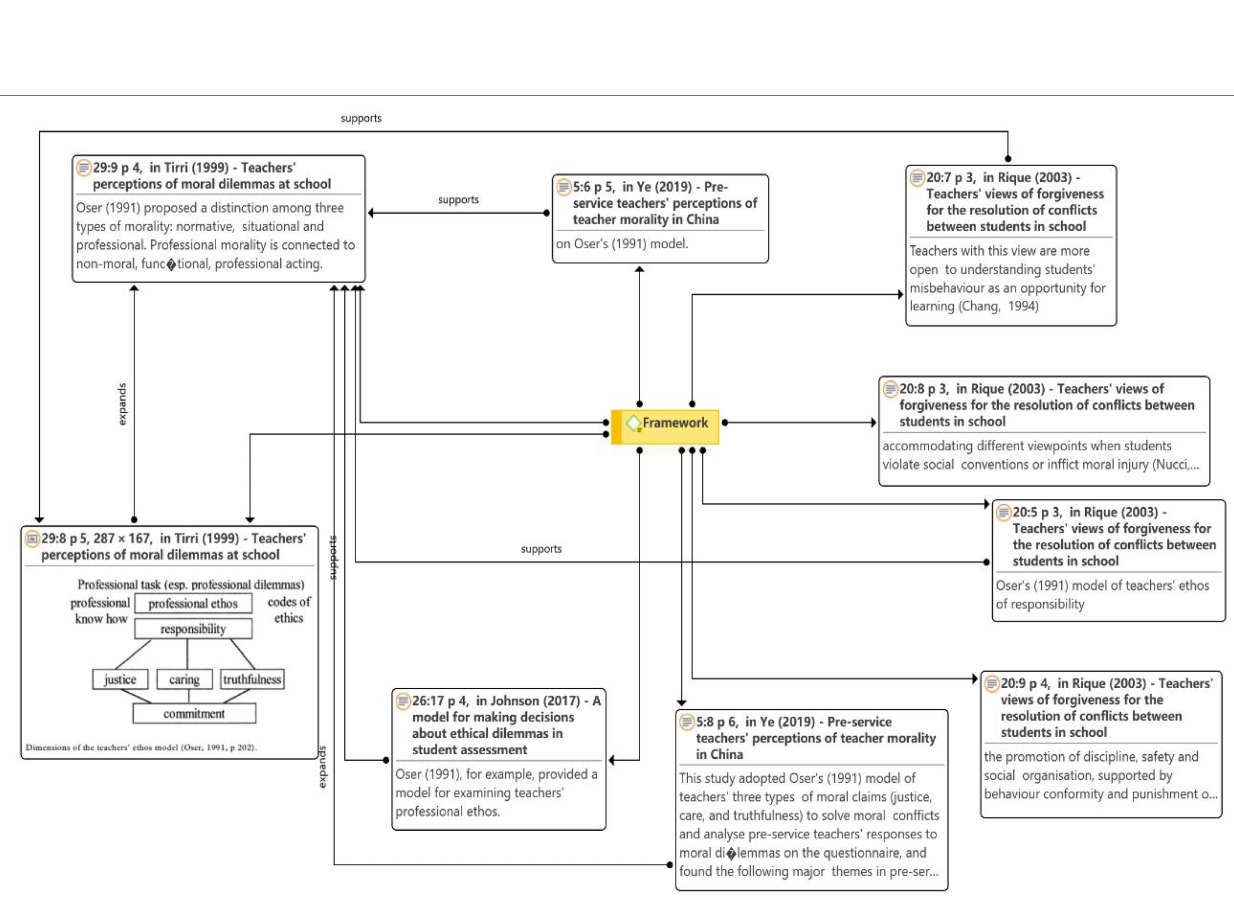
FIGURE 6 | Network on the framework